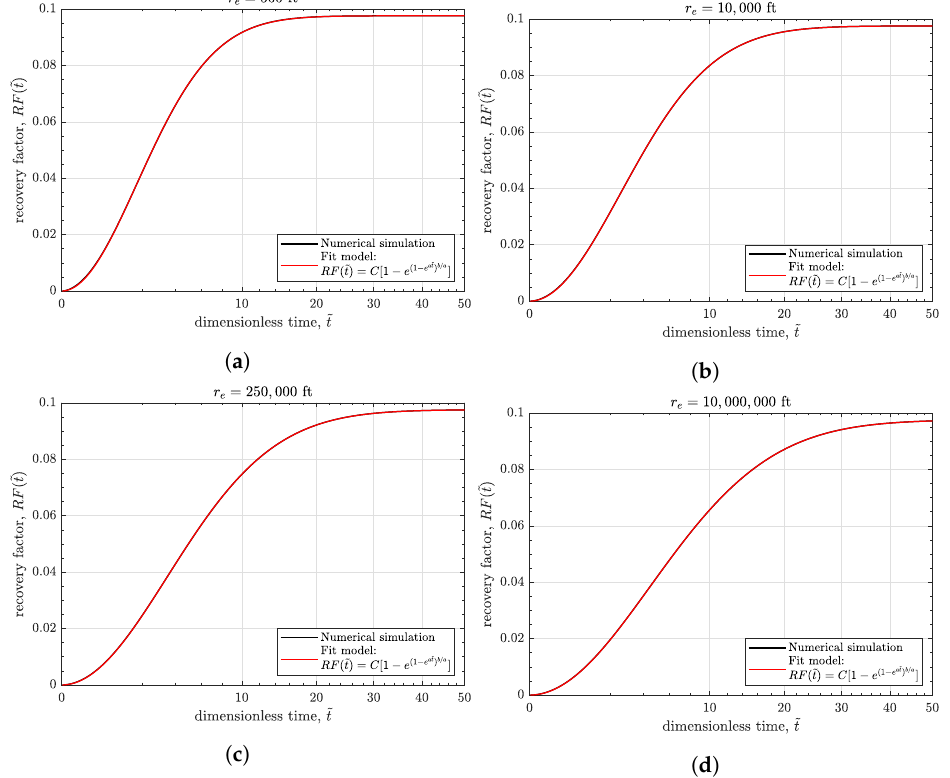
Figure A6. Comparison between the numerical solutions and the corresponding fits from Equation (A28),